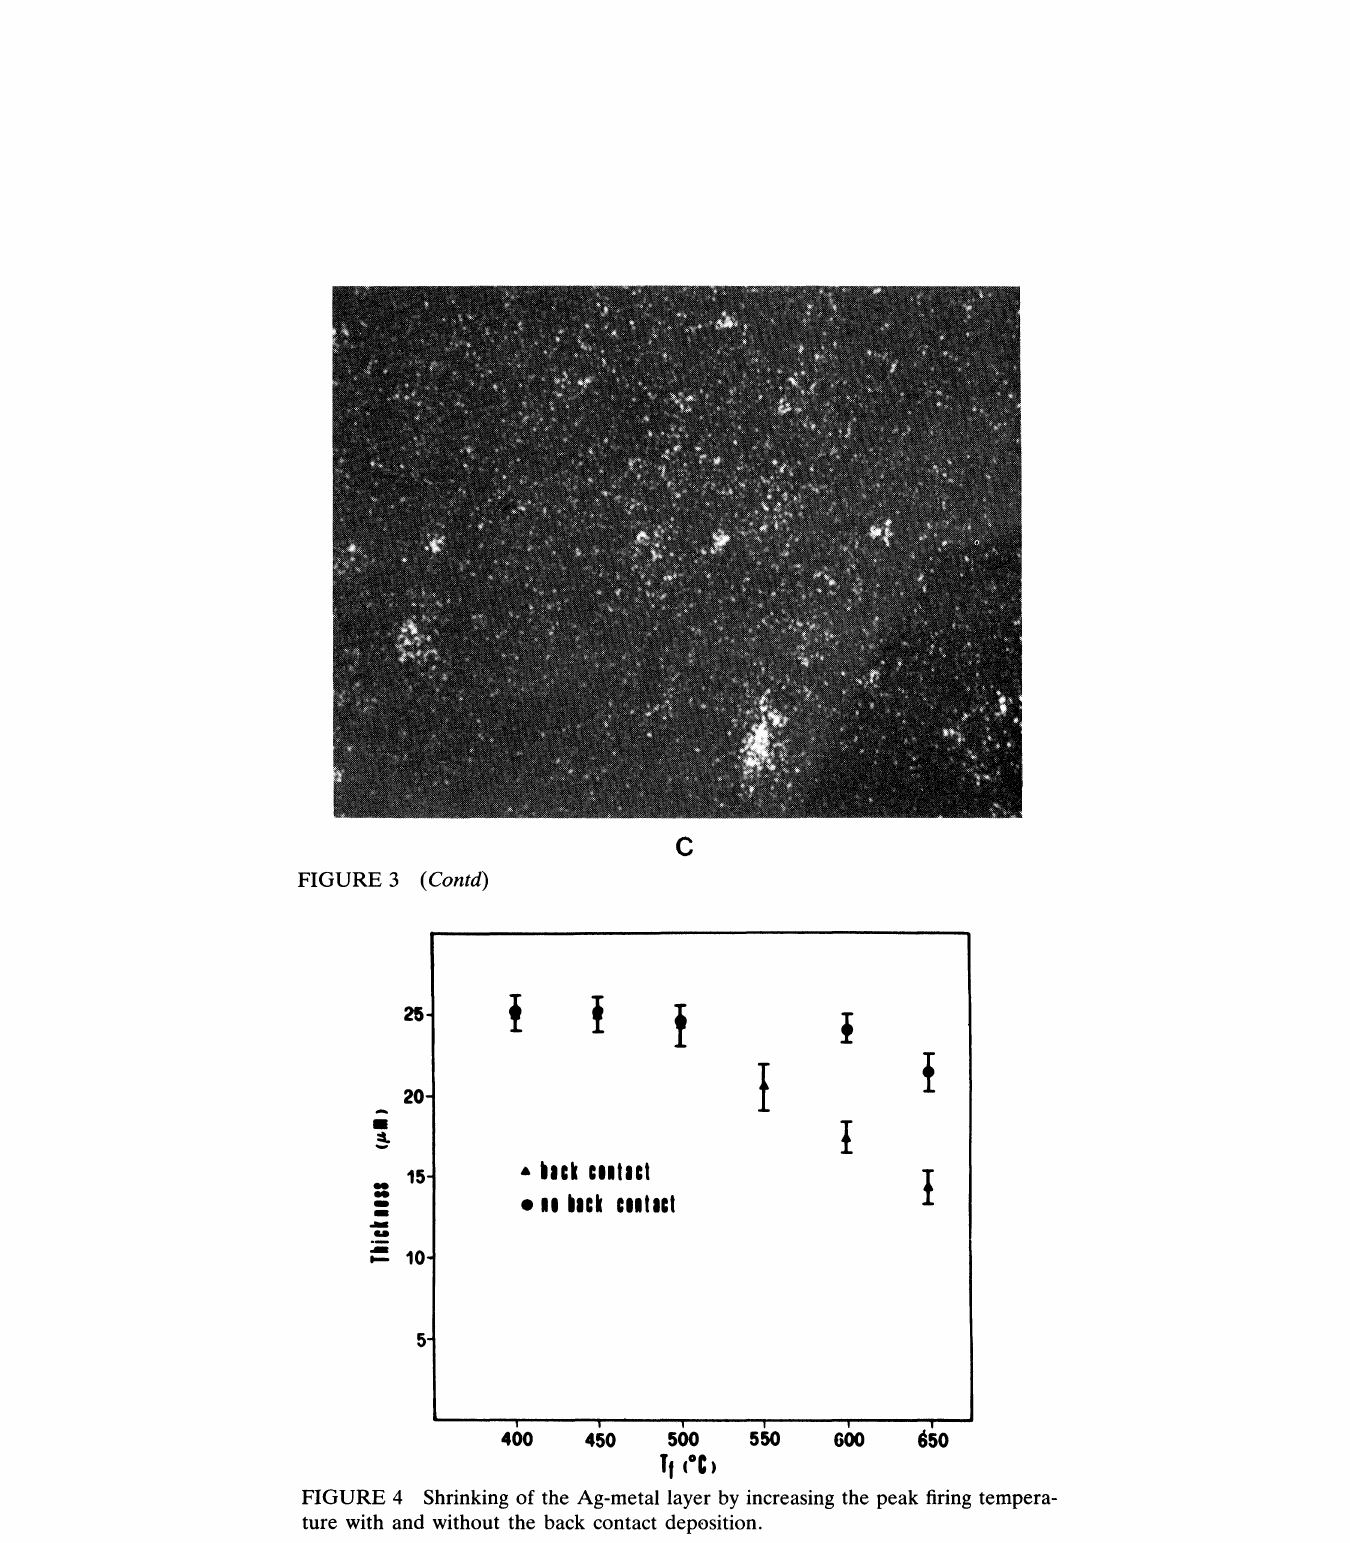
FIGURE 4 Shrinking of the Ag-metal layer by increasing the peak firing tempera- ture with and without the back contact